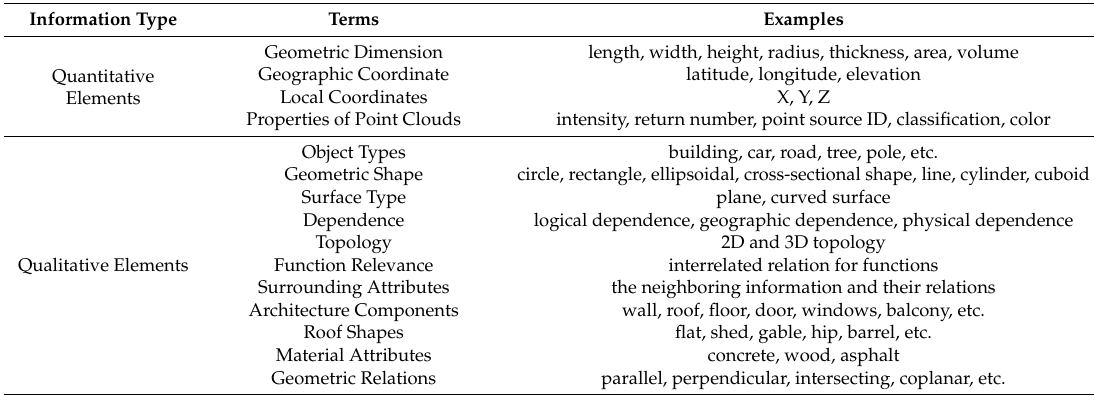
Table 1. Detailed quantitative and qualitative properties in the